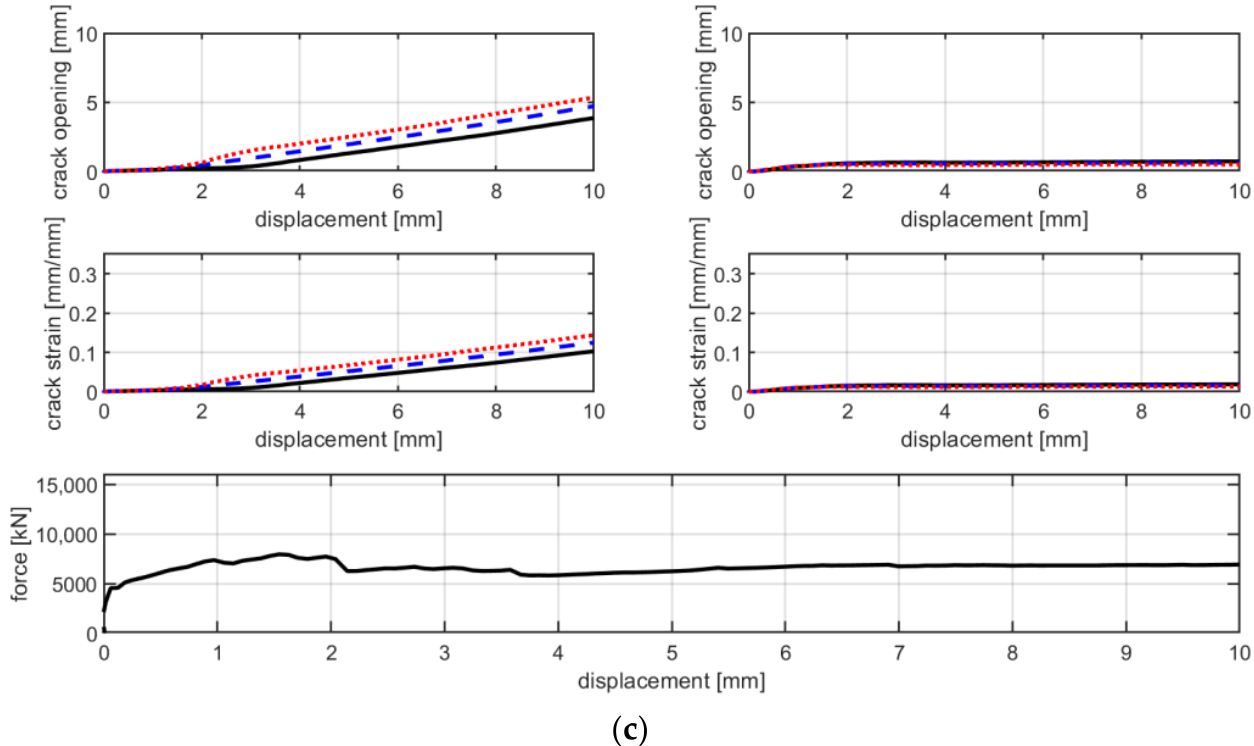
Figure 17. Graphs of crack opening/crack deformation/force-axial displacement of specimens